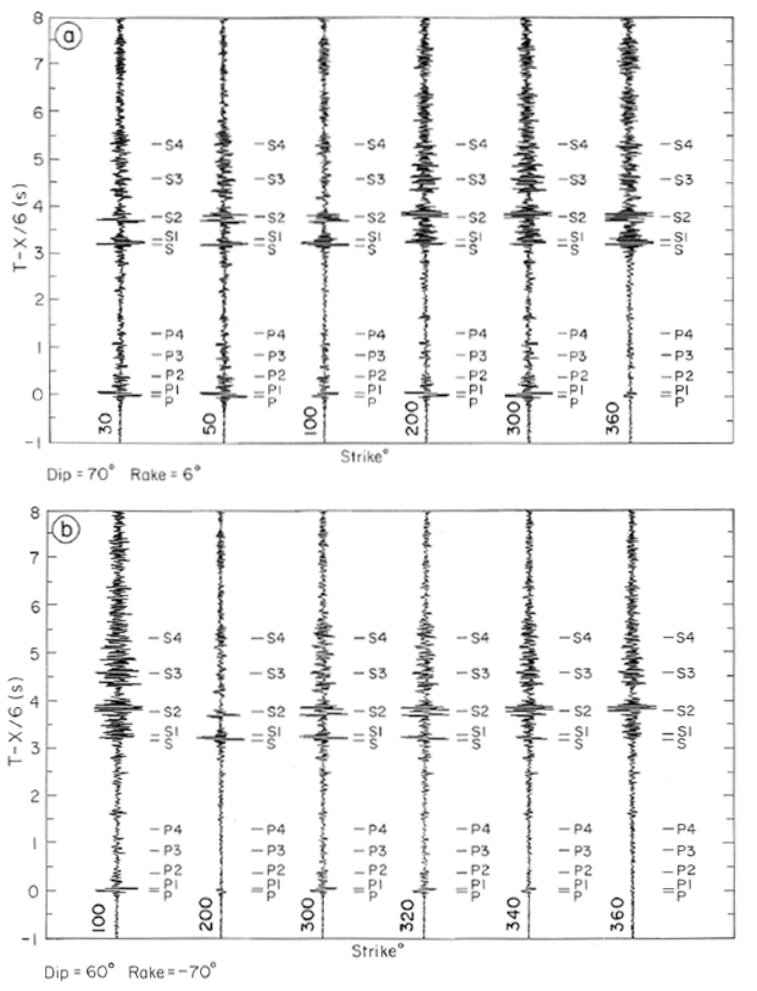
Figure 6. (a) Same as Figure 3a showing amplitude variations as the strike varies for the strike-slip mechanism. (b) Same as Figure 6a for the normal mechanism. Note relatively low amplitude P phases as compared to those for the strike-slip mechanism.